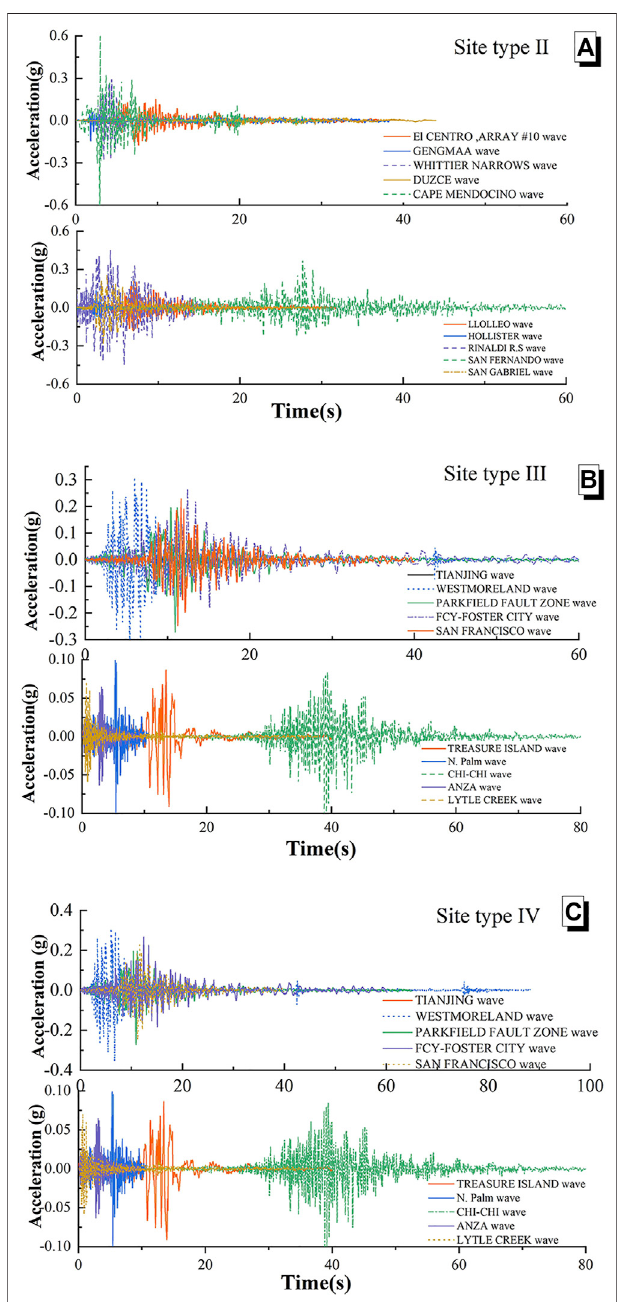
FIGURE 6 | The time history of the ground motions in the different site types. (A) Site type II; (B) Site type III; (C) Site type IV.